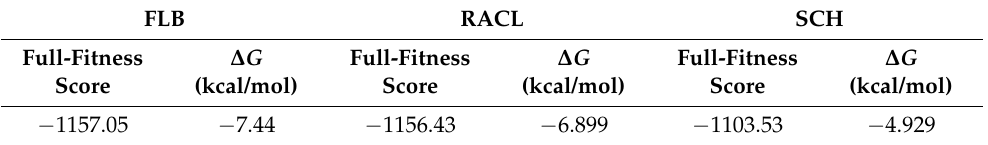
Table 2. Molecular docking results for D2DR-ligand bottom complexes. FLB